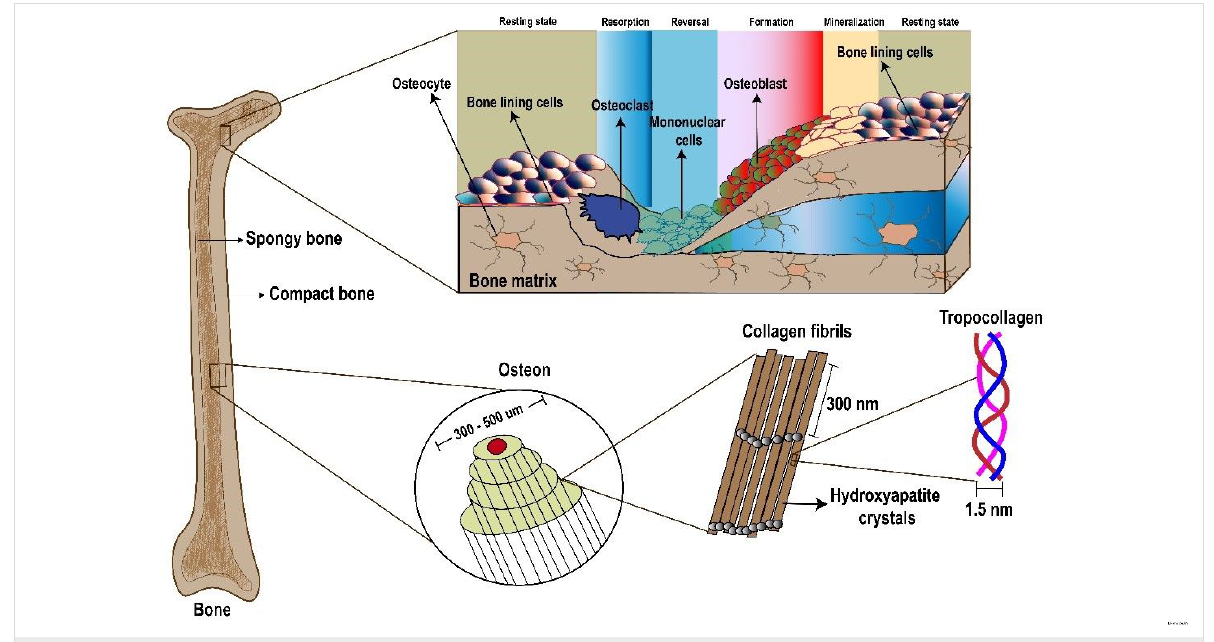
Figure 1: The bone structure. The magnified image shows the physiological arrangement of the bone matrix. The internal structure of the bone has the 100–500 µm osteon which contains 300 nm collagen fibrils, hydroxyapatite crystals, and 1.5 nm tropocollagen.